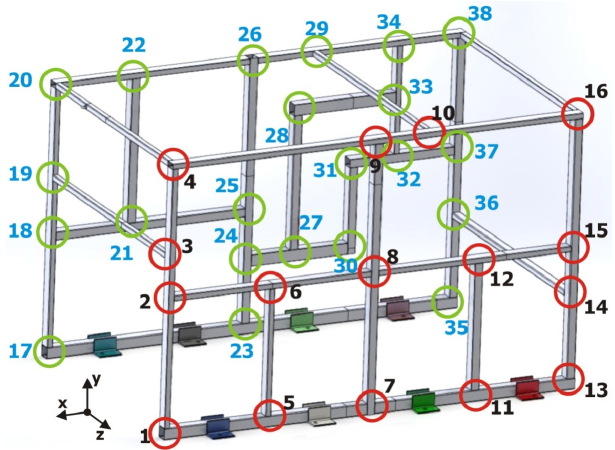
Figure 12. Diagram identifying the total number of joints in the validation structure.